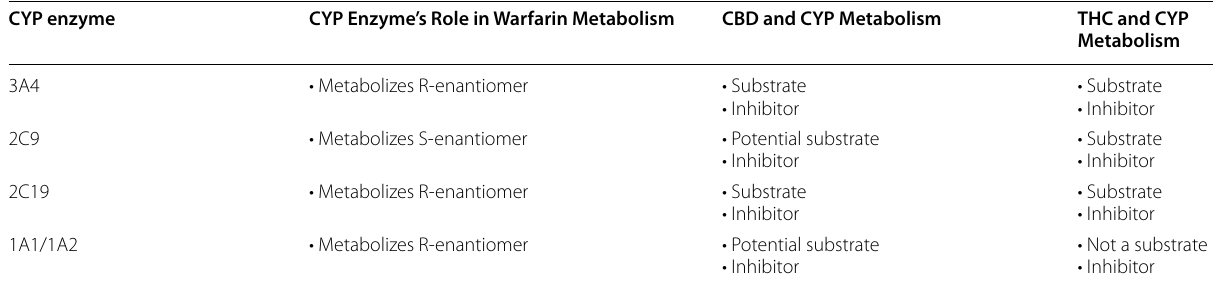
Table 4 CBD and THC interactions with enzymes associated with warfarin metabolism (Health Canada 2018; Yamaori et al. 2012; Anderson and Chan 2016; Sachse-Seeboth et al.